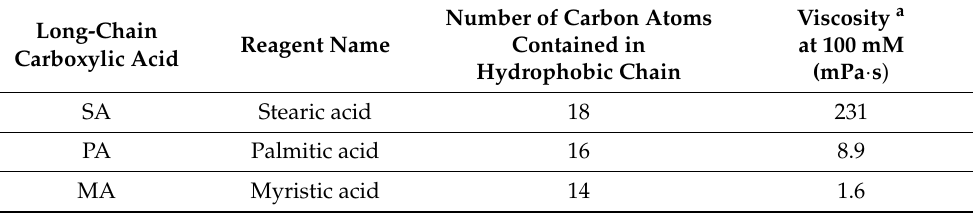
Table 2. Comparison of different long-chain carboxylic acids mixed with cyclen (molar ratio, 4:1). Long-Chain